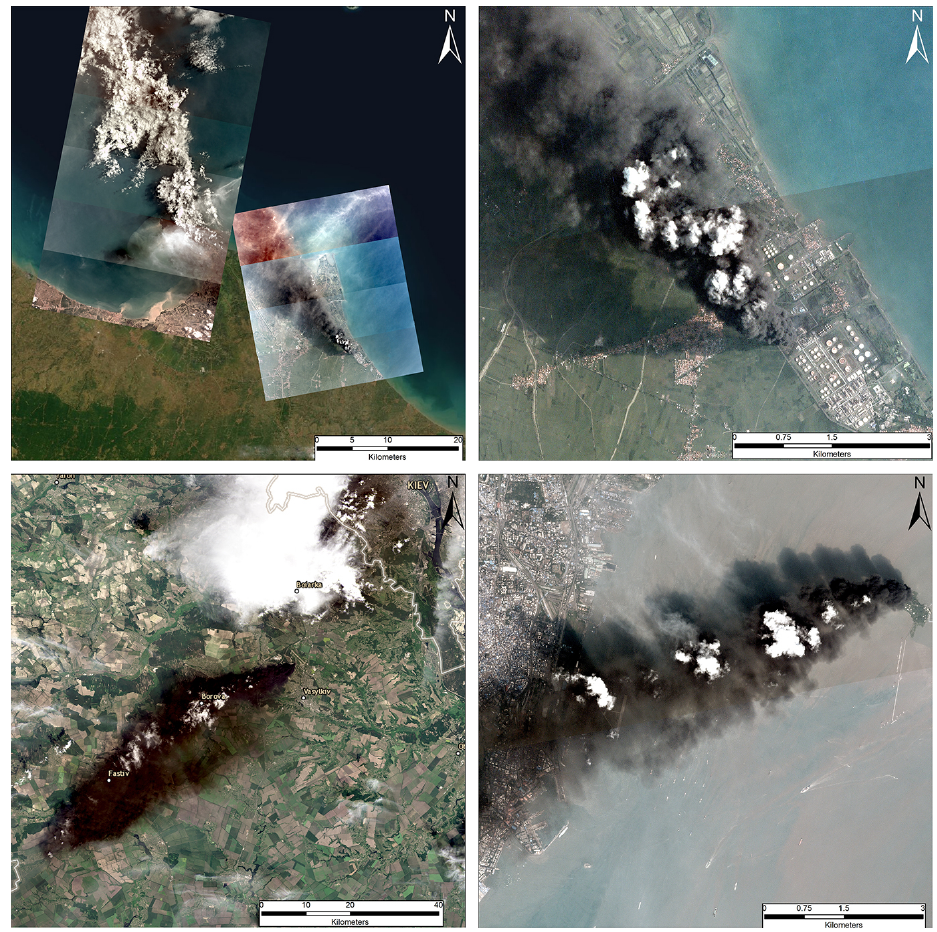
Figure 6. Cloud formation on top of oil smoke plumes. Upper images depicting the fire at Balongan, Indonesia, 29 March 2021; lower left image depicting the fire at Vasylkiv, Ukraine, on 9 June, 2015; lower right image depicting the fire at Butcher Island, India, on 7 October 2017 (satellite imagery from OpenStreetMap©OpenStreetMap contributors, 2021. Distributed under the Open Data Commons Open Database License (ODbL) v1.0 and Planet Team, https://www.planet.com/, last access: 5 January